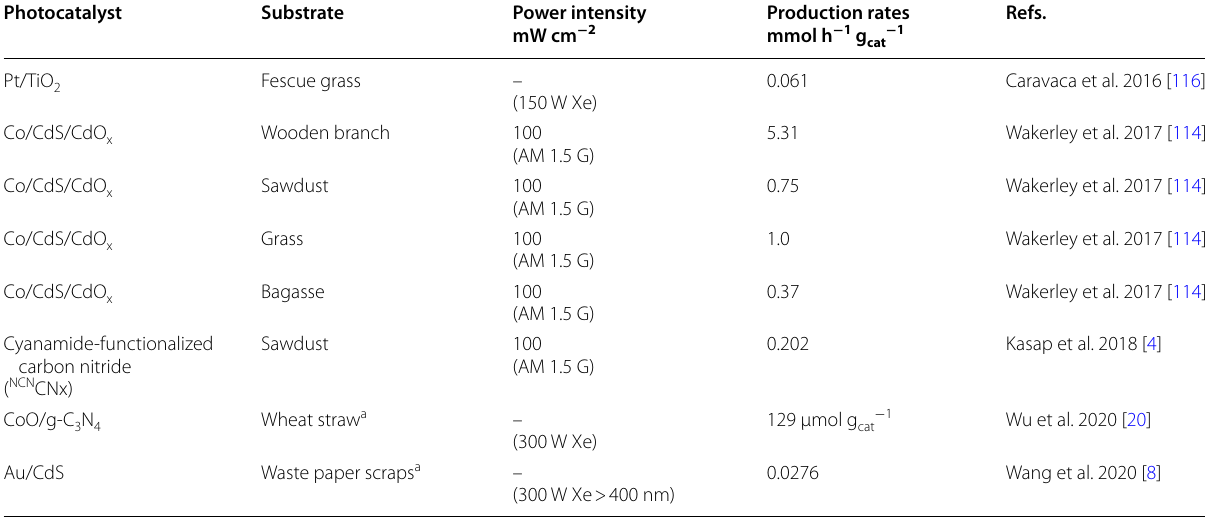
a These studies did pretreat the biomass substrate prior to photocatalytic utilization